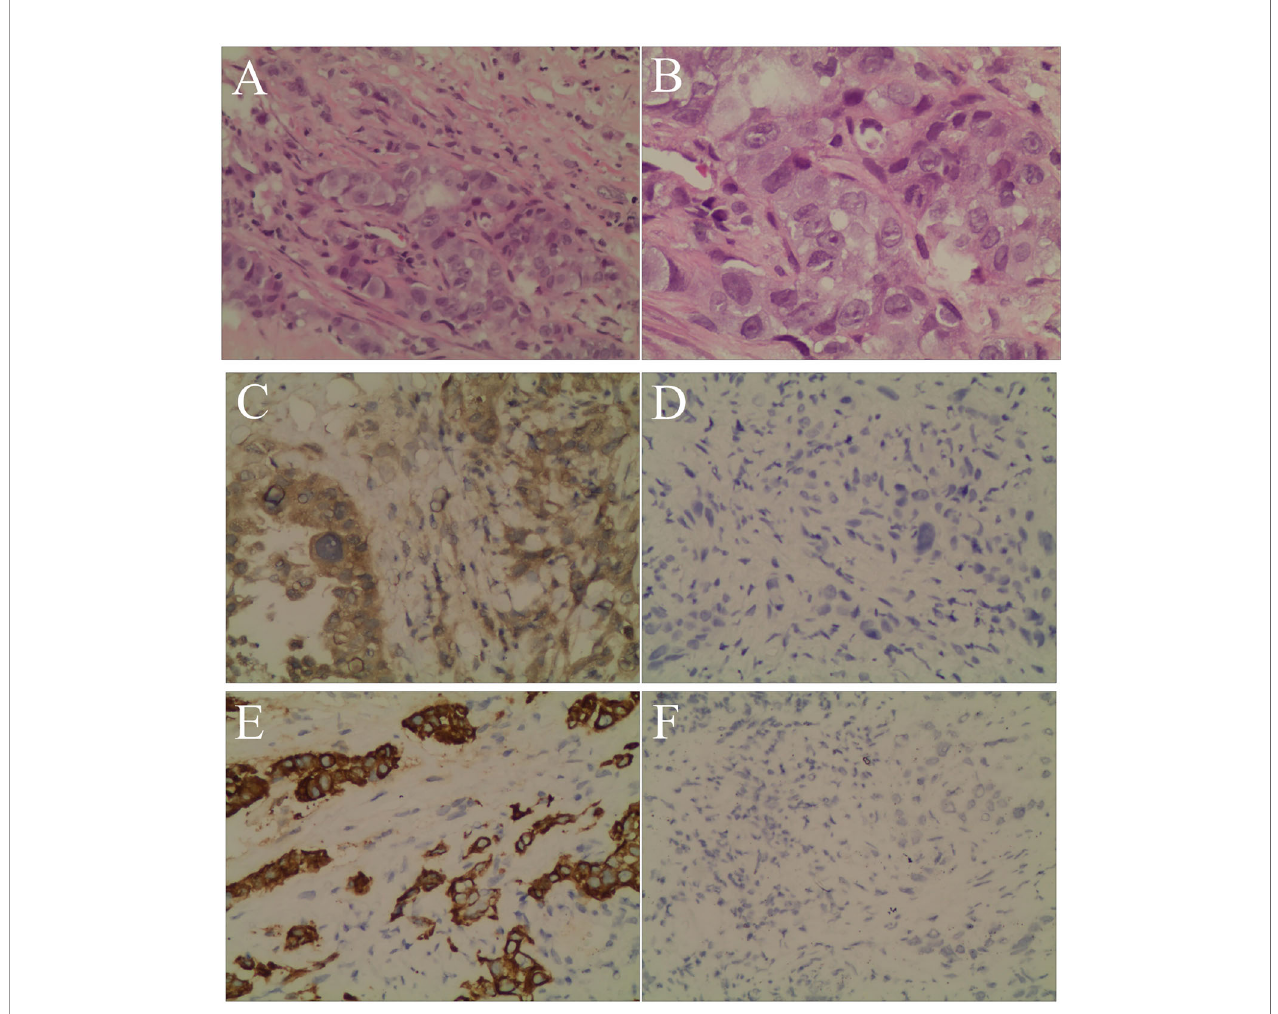
FIGURE 3 | Hematoxylin and eosin staining and immunohistochemistry. (A) Neoplastic cells arranged in an alveolar pattern and the glandular lumen can be seen in the lesion area (magni fi cation, ×200). (B) Neoplastic cells with prominent and hyperchromatic nucleoli, nuclear pleomorphism, and abundant eosinophilic cytoplasm, consistent with an adenocarcinoma with hepatoid differentiation (magni fi cation, ×400). (C) The tumor cells were positive for GPC-3 (magni fi cation, ×200). (D) The tumor cells were negative for hepatocyte (magni fi cation, ×200). (E) The tumor cells were positive for CK7 (magni fi cation, ×200). (F) The tumor cells were negative for TTF-1 (magni fi cation,